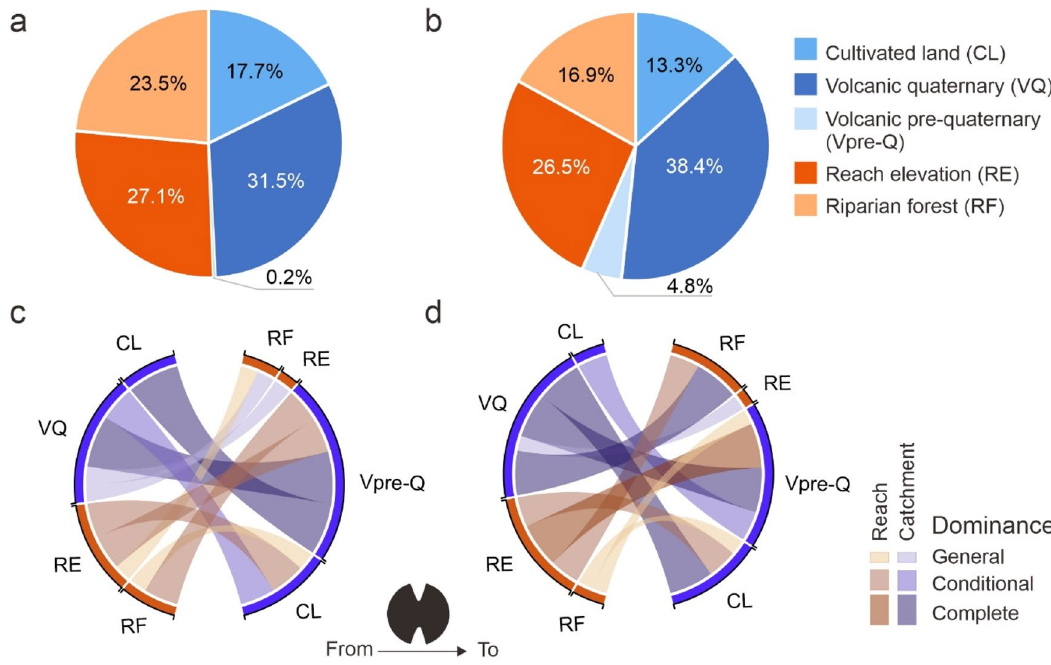
Figure 2. Relative importance and pair-wise dominance analysis among environmental covariates. ( a - b ) Relative importance for each environmental covariate in the ( a ) daily and ( b ) monthly regression models measured using the marginal coefficient of determination R 2 and expressed as their overall average contribution towards the observed variance in water temperatures explained by the full model after accounting for the effect of air temperature (baseline model). ( c - d ) Chord diagrams showing the pairwise dominance relationships between covariates in terms of their relative contribution towards explained variance across all possible subset models for the ( c ) daily and ( d ) monthly models. Dominance is established from the left side predictors towards the right side predictors in the diagrams; the width and colour of the link indicating the dominance level. Three hierarchical levels of dominance are established according to the strength of the control of one variable over the other, which are in decreasing order: complete dominance (i.e., for all individual subset models), conditional dominance (i.e., averaged over subset models for each model size), and general dominance (i.e., averaged